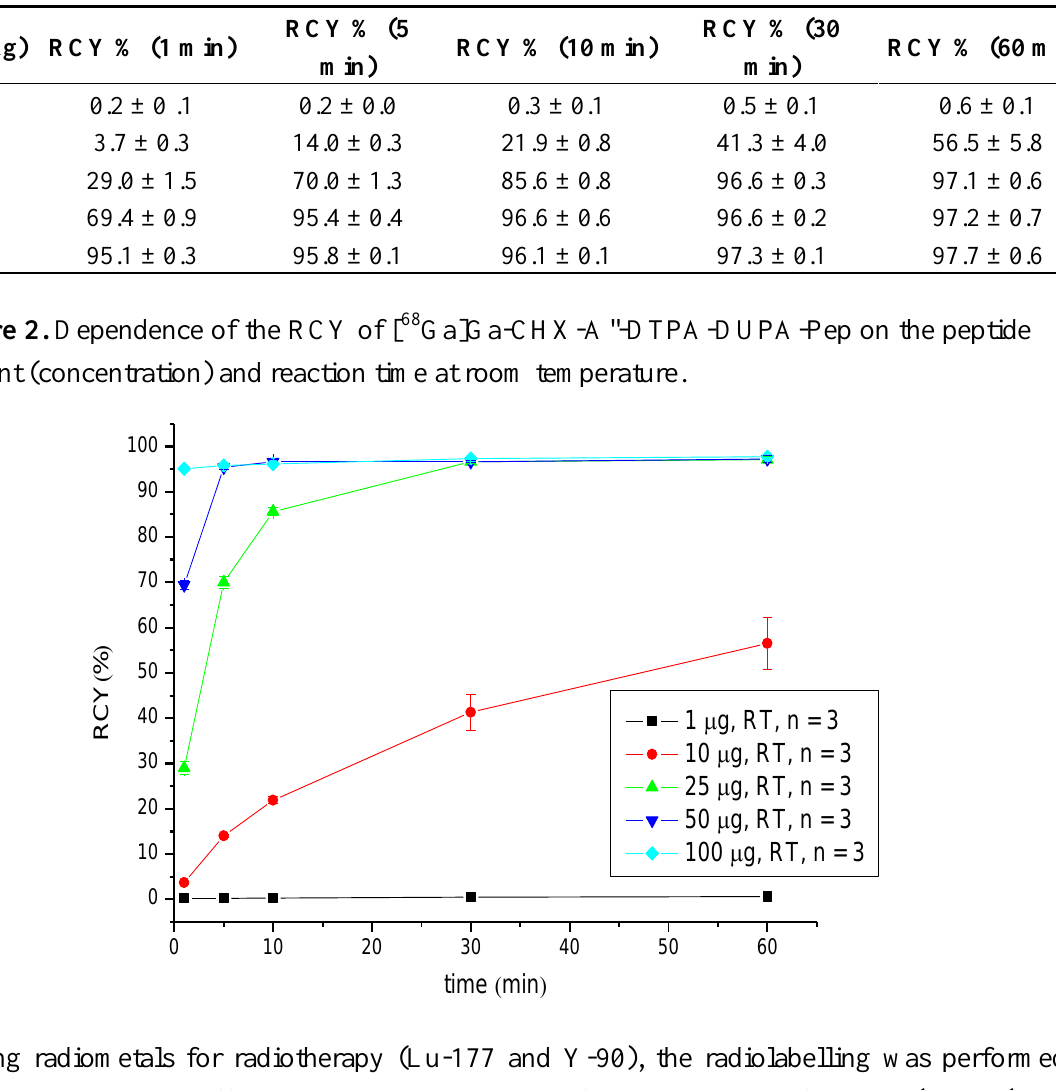
Table 1. Dependence of the radiochemical yield (RCY) of [ 68 Ga]Ga-CHX-A''-DTPA- DUPA-Pep on the peptide amount (concentration) and the reaction time at room temperature.